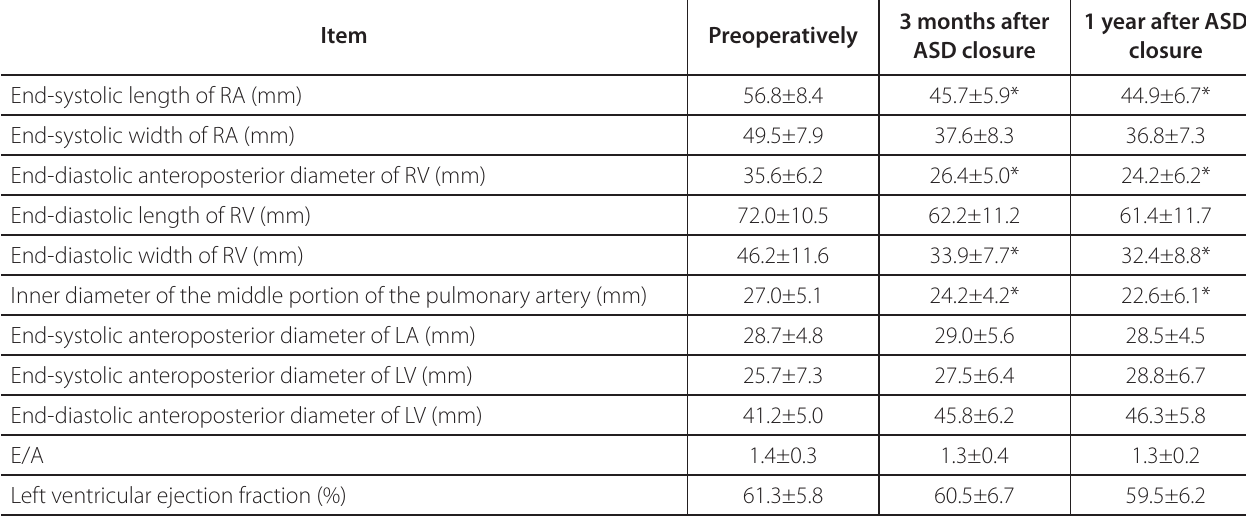
Table 2 . Changes of echocardiographic parameters after ASD